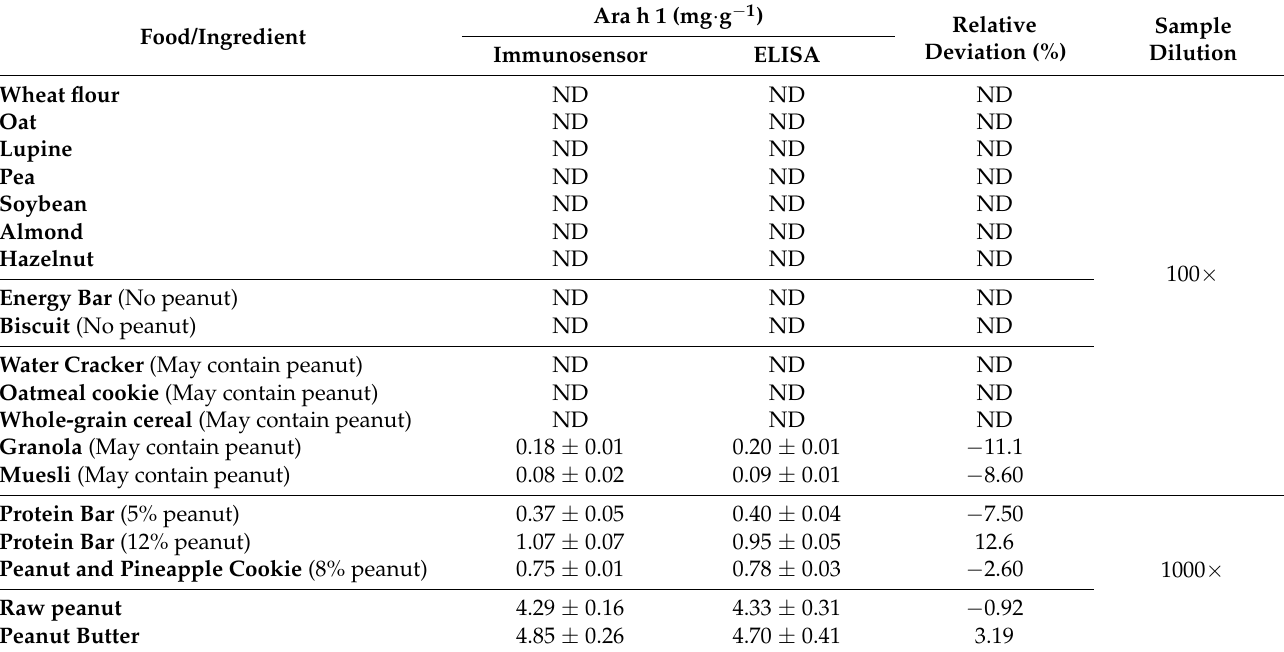
Table 2. Results using the voltammetric SPCE/ND immunosensor and a commercial ELISA kit